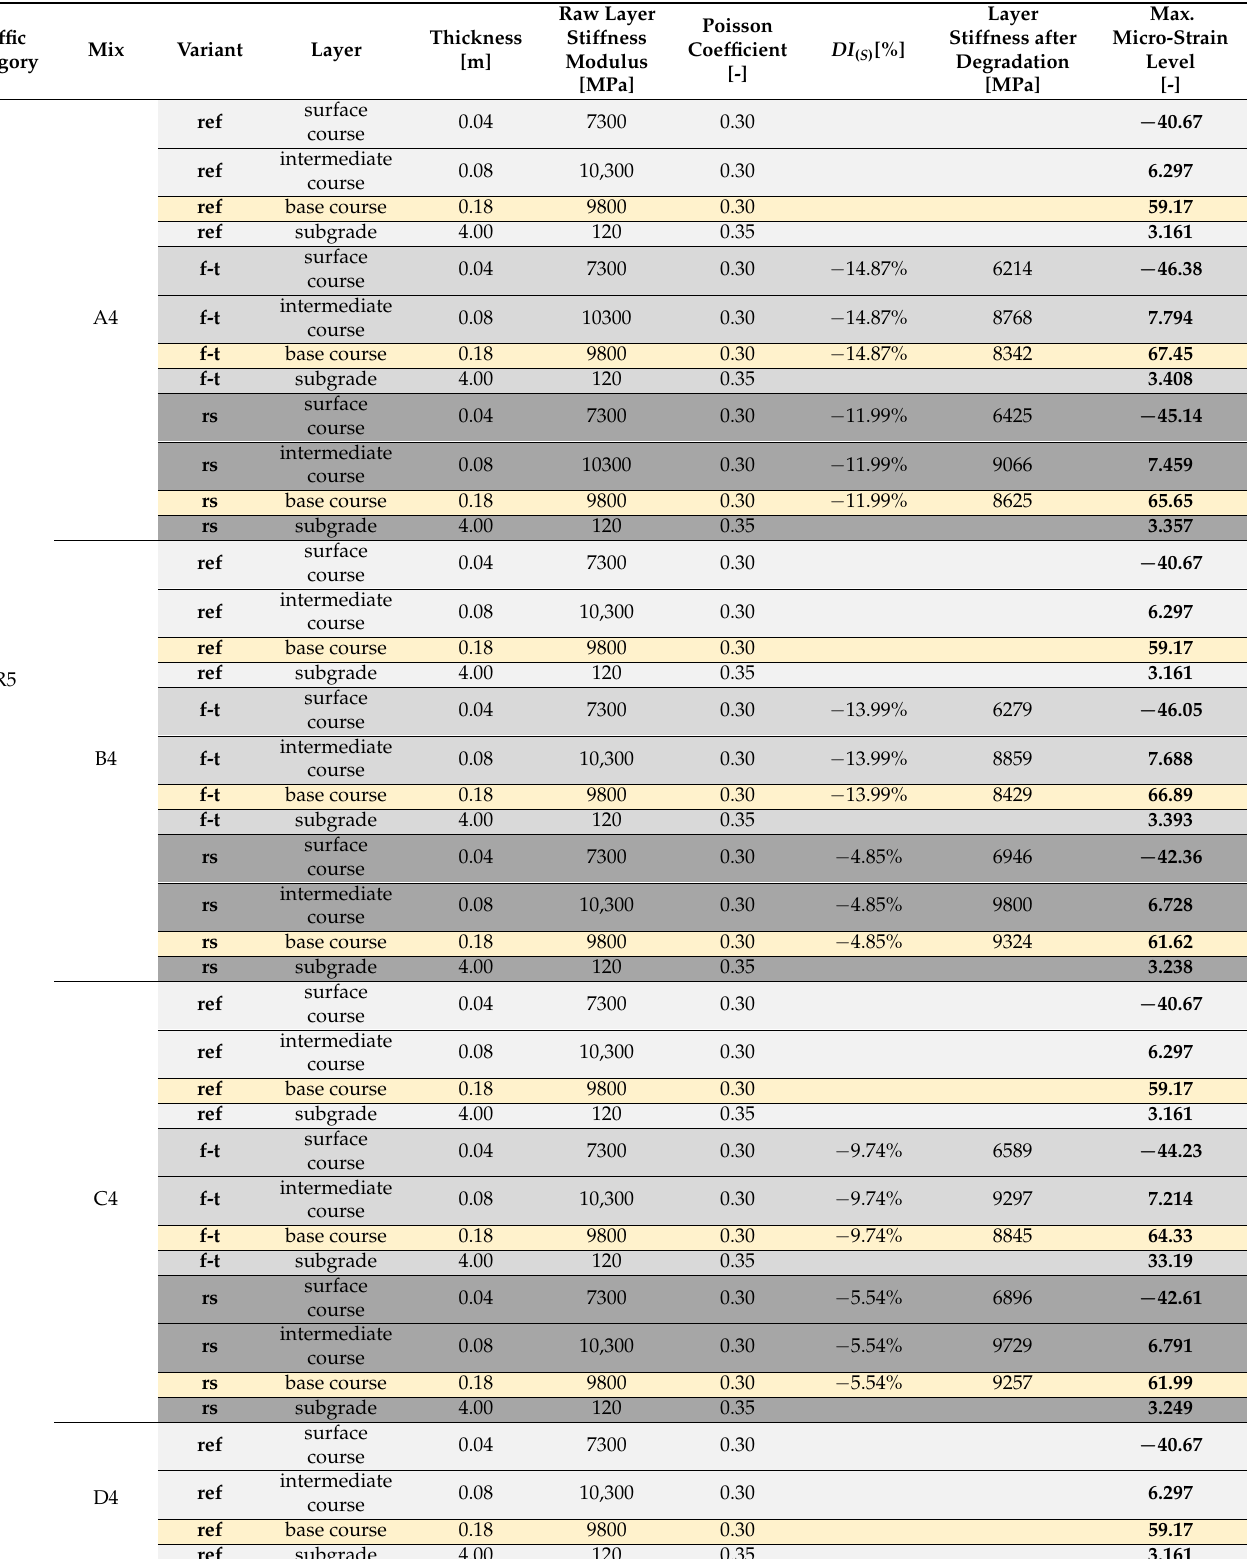
Table 5. Degradation assumptions and modeling